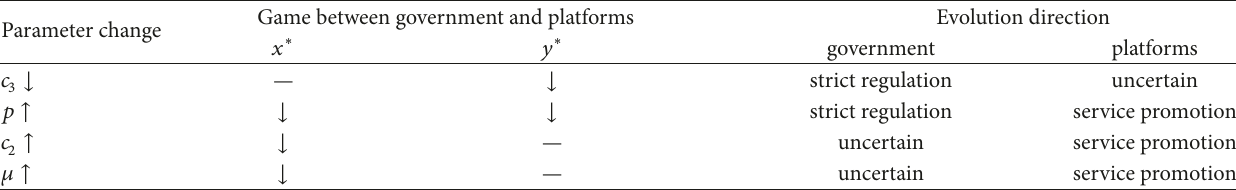
Table 8: Parameters’ effects on evolutionary game